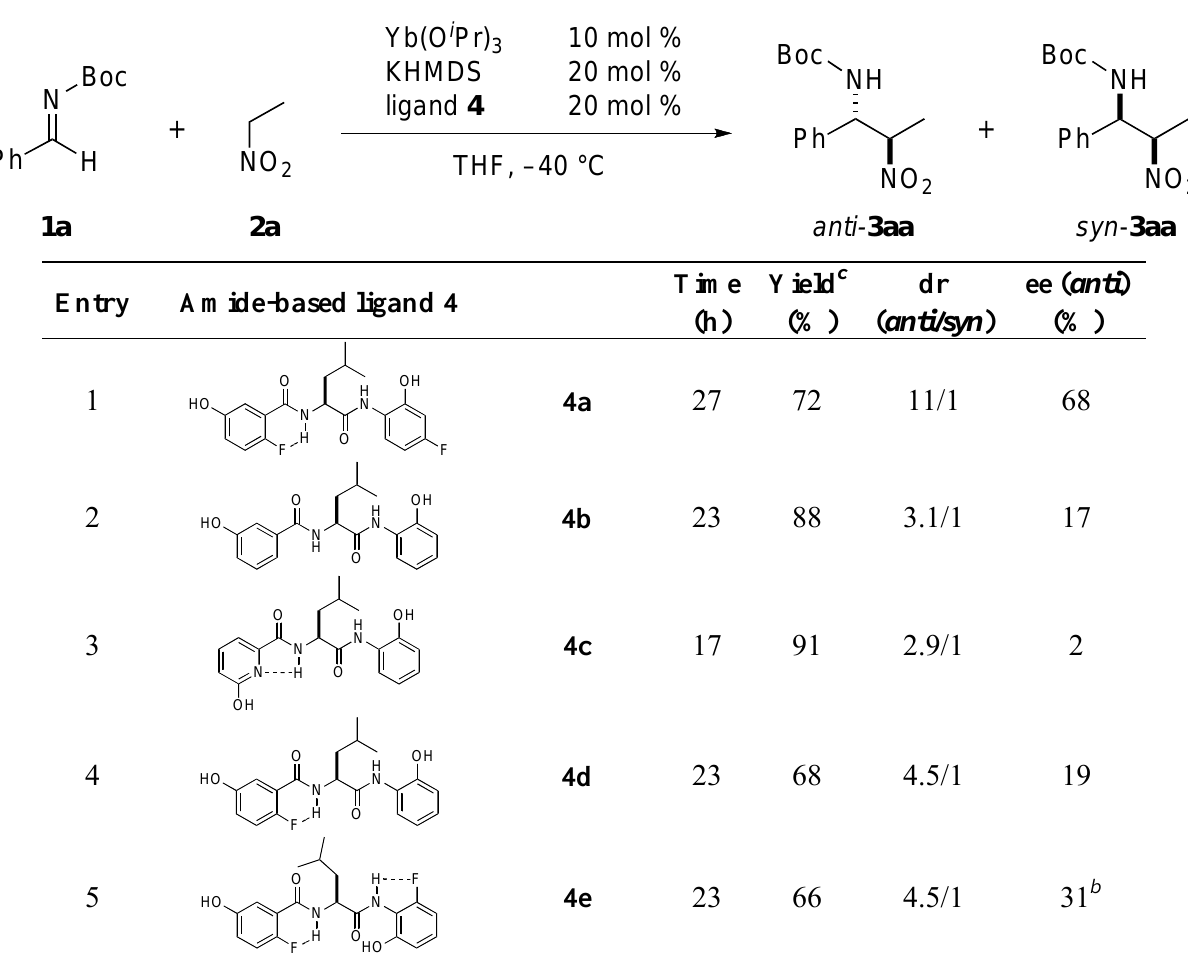
Table 3. Catalytic asymmetric nitro-Mannich reaction promoted by RE/K/ 4 heterobimetallic catalysts.